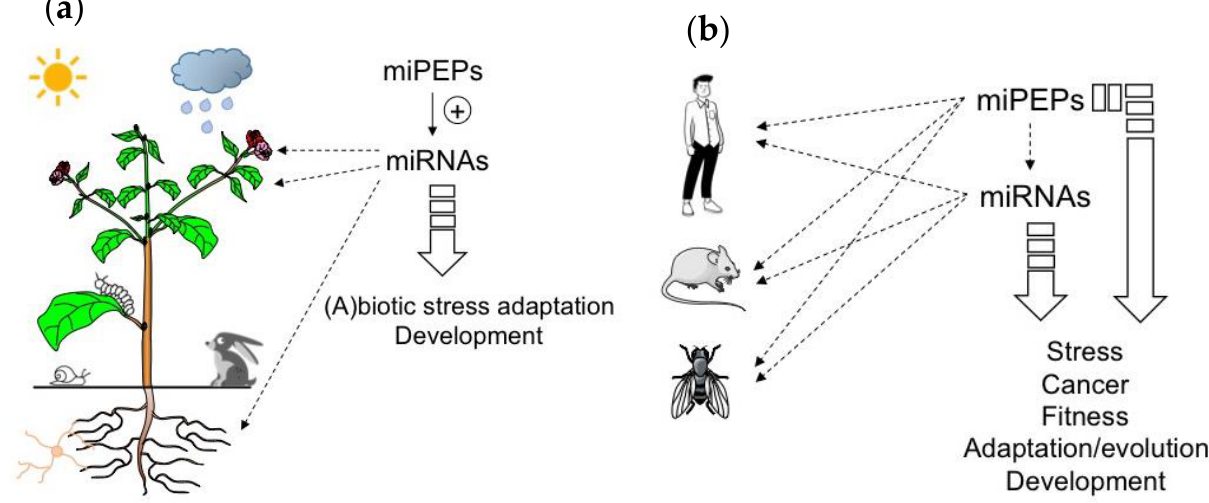
Figure 1. MicroRNA-encoded peptides (miPEPs) regulate many biological functions both in plants and animals. ( a ) The ability of plant miPEPs to positively regulate the expression of their respective pri-miRNAs is described for several miPEPs and plant species. ( b ) Conversely, in animals, the regulation of pri-miRNAs by miPEPs is less clear. MiPEPs frequently act independently.